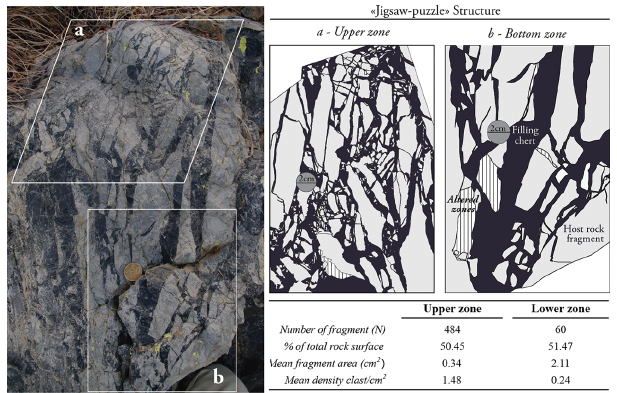
Figure 6. Highly fractured zone with jigsaw fit texture. Sketches (a, b) highlight the structures in the upper and lower zone respec- tively. Rocks are brecciated into small, elongated, angular and min- imally displaced fragments separated by a network of thin (mm to cm) black chert veins. The table contains the comparative statistical analysis of the upper and lower zones. In order, we give the number of fragments ( N ), the percentage of surface they occupy in the pic- ture, their mean surface (representative of fragment size), and their spatial distribution expressed in density (number of clast per square centimetre). Fracturing intensity increases towards the top of the structure, where fragments are smaller and much more abundant. In the lower zone, veins are wider, showing a lack of settling of rock fragments.